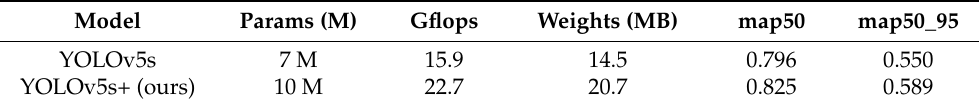
Table 3. Test of improved YOLOv5s on the VOC2007 + 2012 dataset.